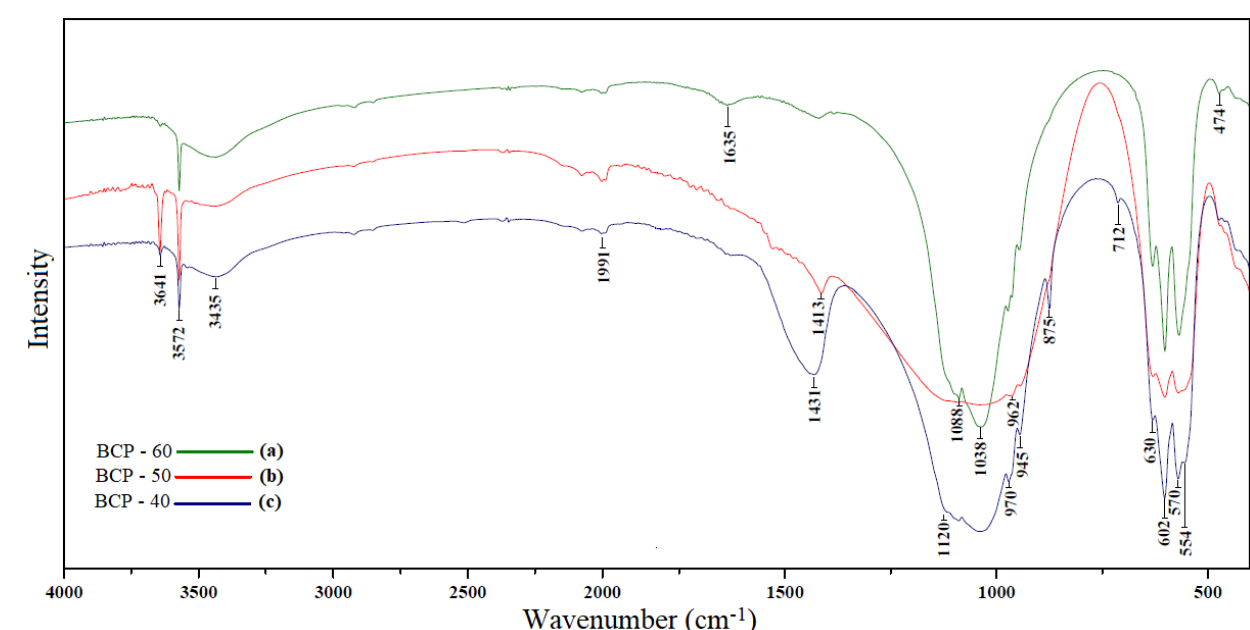
Figure 3. Infrared spectra of BCP-60 (a), BCP-50 (b), and BCP-40 (c). TCP phase are 3572 and 630 cm − 1 . They are referenced to the stretching and vibration modes of the structural groups (OH) on the lattice of the HAp crystallite, respectively. In addition, the band at 3641 cm − 1 probably belongs to calcium hydroxide, Ca(OH) 2 . The samples [20,21].